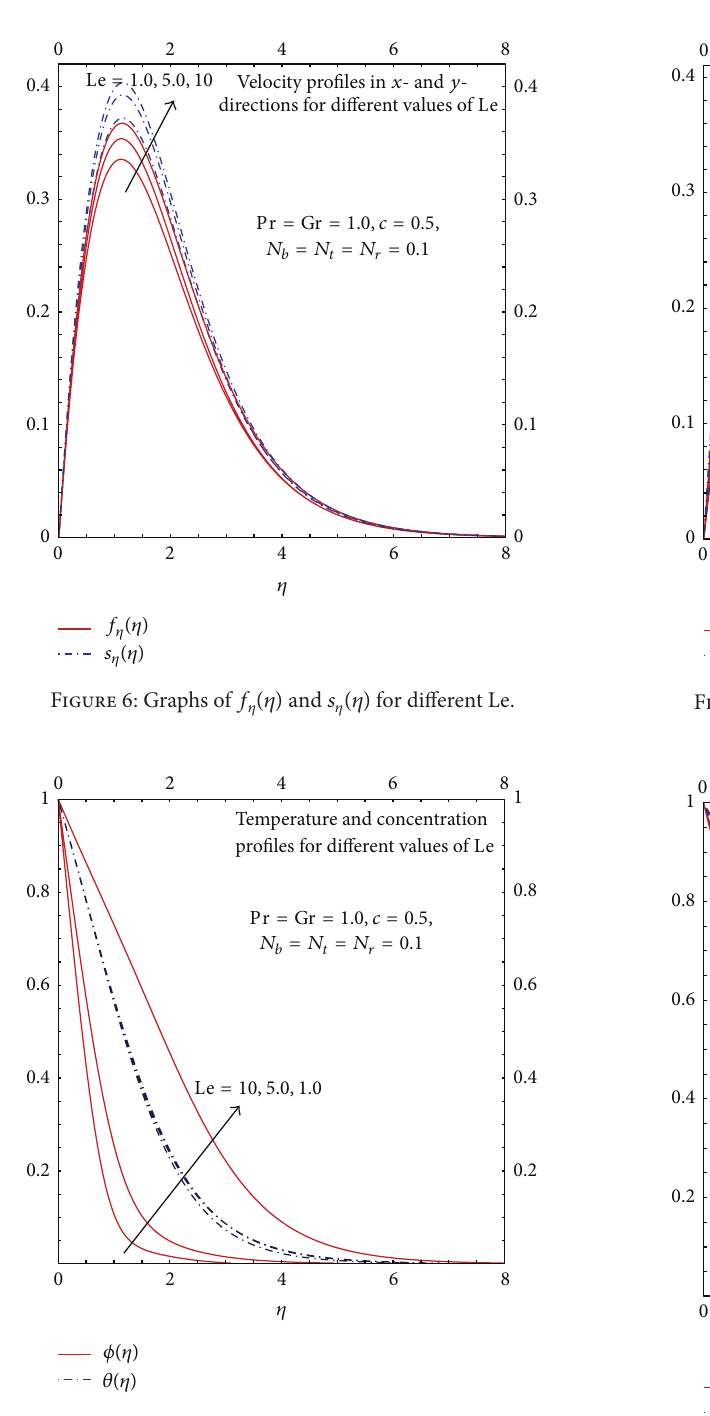
Figure 7: Graphs of 𝜃 𝜂 (𝜂) and 𝜙 𝜂 (𝜂) for different Le. fluid because the fluid conducts heat slowly relative to its volumetric heat capacity.